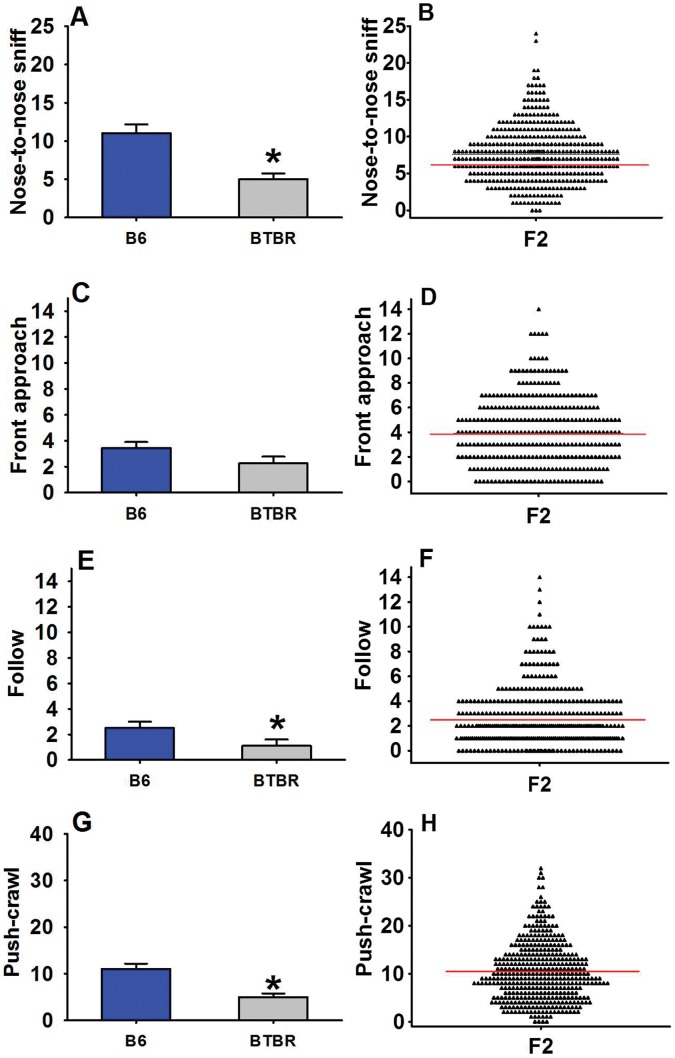
Juvenile social interactions in B6, BTBR, and F2 mice.(A) As compared to B6, BTBR exhibited significantly lower levels of nose-to-nose sniff, (E) follow, (G) push-crawl, (C) and a trend toward lower levels of front-approach. (B, F, H, D) In the present study, F2 subjects exhibited broad ranges of these behaviors. A, C, E, G display Mean ± SEM; bold red line in B, D, F & H indicates mean value. B6 and BTBR data from A, E and G are adapted from Yang et
al., 2009, European Journal of Neuroscience, Copyright (c) 2009, Blackwell Publishing, Ltd., with reuse and reprint permission via the Copyright Clearance Center (CCC).